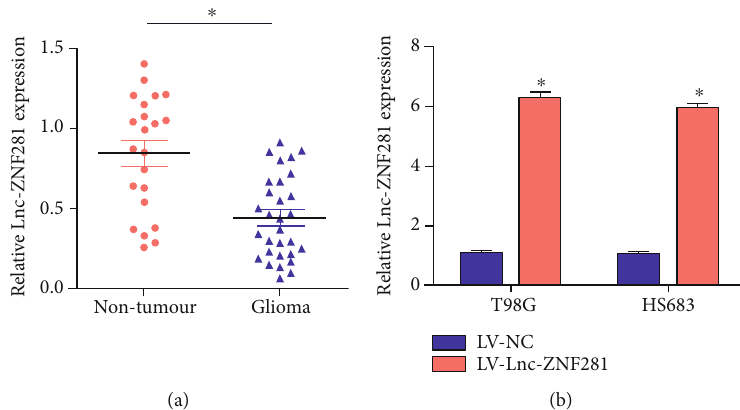
Figure 1: Expression levels of lnc-ZNF281 were reduced in glioma tissues. (a) qRT-PCR results indicated lnc-ZNF281 had a low expression level in glioma tissues compared to normal brain tissues. (b) qRT-PCR results indicated that the expression level of lnc-ZNF281 in glioma cells increased signi fi cantly after lentiviral transfection. ∗ p < 0 : 05 .